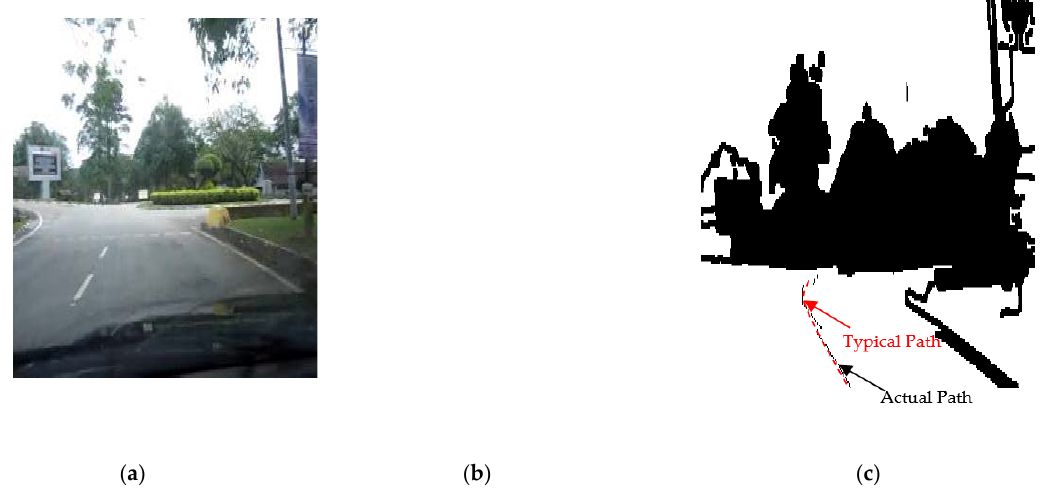
processing, and ( c ) generation of the path within the road following environment.